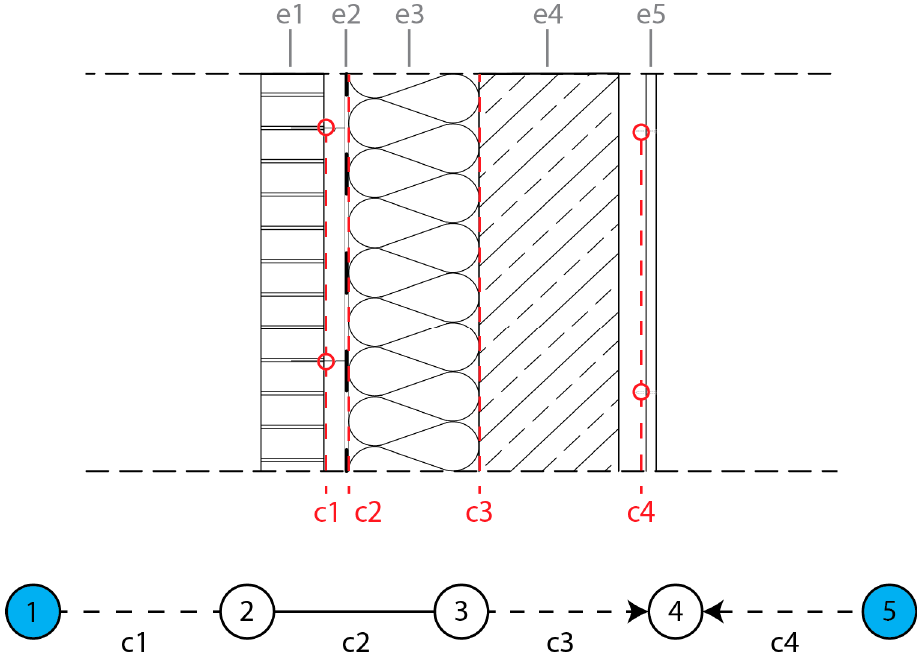
Figure 2. Vertical section and network visualization of the façade wall. The direction of a connection is indicated by an arrow and its potential to be unfastened by a dashed line. On this network, the arrows indicate the direction of the connection. A full line indicates an irreversible connection, a dashed line indicates a reversible connection. The elements in blue circles are directly accessible. Fictive values for the elements and connections are indicated in Tables 3 and 4, respectively. Table 3. Values for the elements in the (fictive) façade wall example. These values were arbitrary chosen to illustrate the principle behind the DNA method.